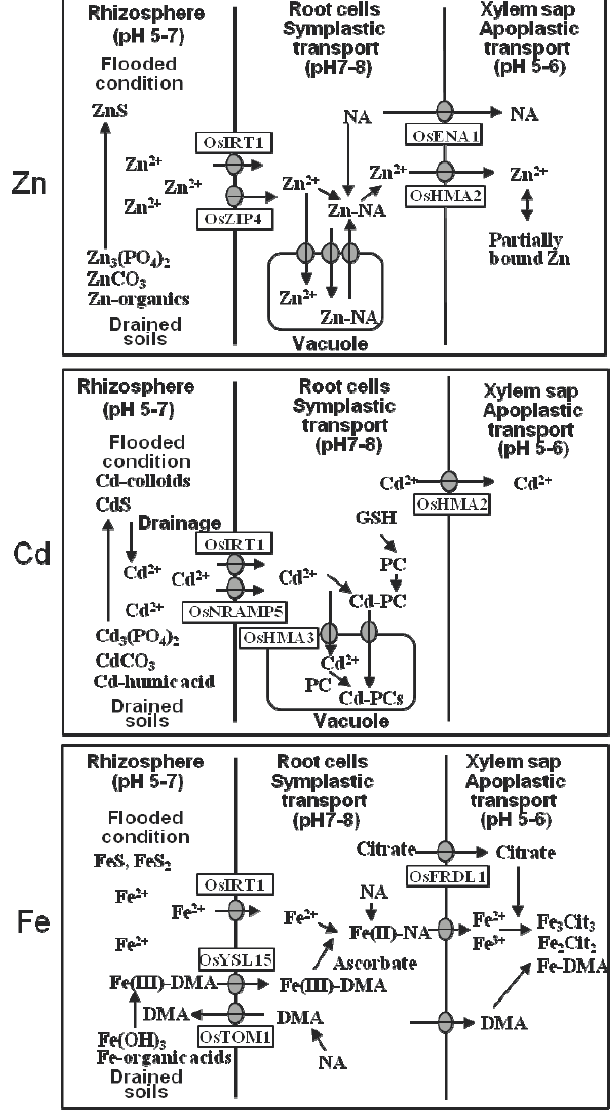
Figure 2. Models of uptake and transport of Zn, Cd, and Fe in rice roots. DMA, 2 ′ -deoxymugineic acid; GSH, glutathione; NA, nicotianamine; PC, phytochelatin. Arrows indicate flows of substances and grey ellipses indicates